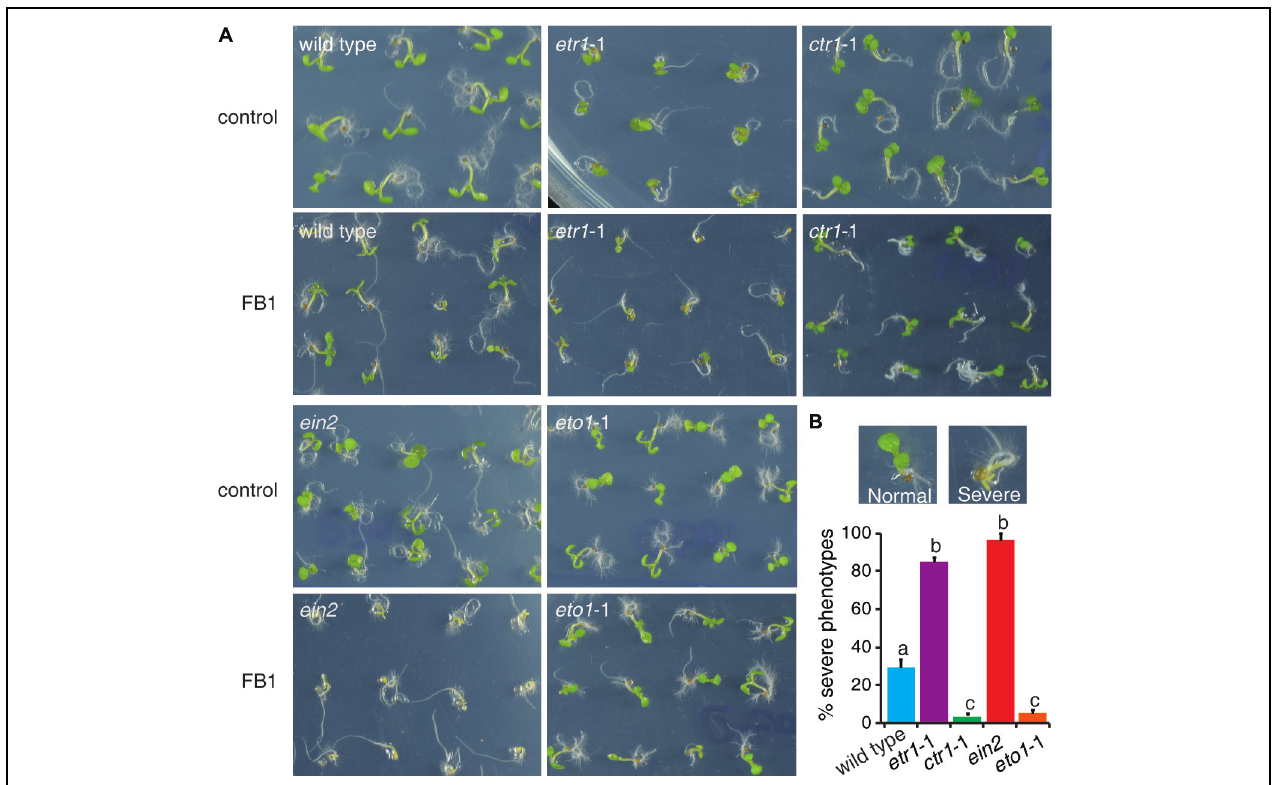
FIGURE 1 | Responses of mutants involved in ethylene signaling to FB1 treatment. (A) The wild-type, etr1 -1, ein2 , ctr1 -1, and eto1 -1 seeds were germinated on 1/2x MS with or without 0.5 µ M FB1. Photos were taken after 6 days of treatment. (B) Quantitation of the phenotypes in (A) . Seedlings with cotyledon bleaching were scored as having a severe phenotype. The data represent means of three independent experiments. At least 40 seeds of each sample were used in each experiment. Data are means ± SD ( n = 3) and sets marked with different letters indicate significances assessed by Student–Newman–Keul test ( P < 0.05).